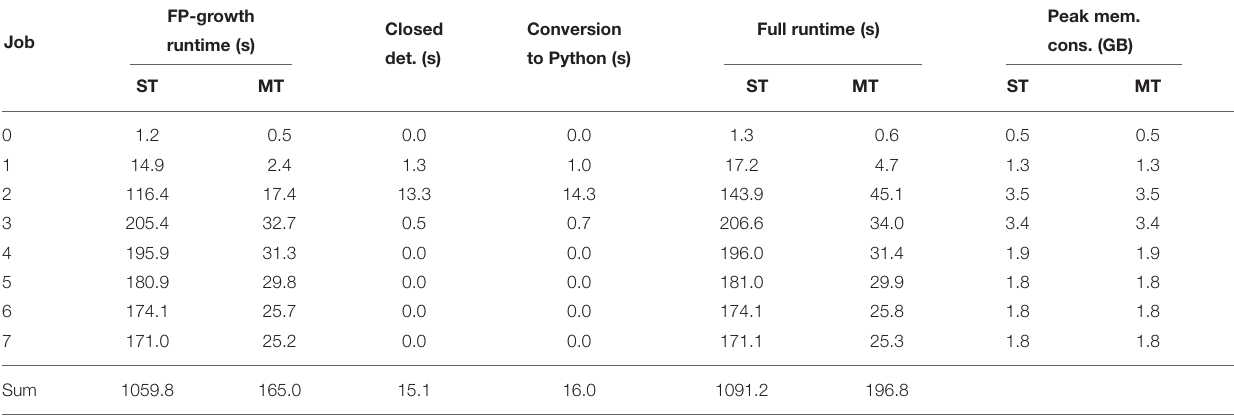
TABLE 3 | Workstation runtime of the optimized implementation in single (ST)- and multi (MT)-threaded mode.